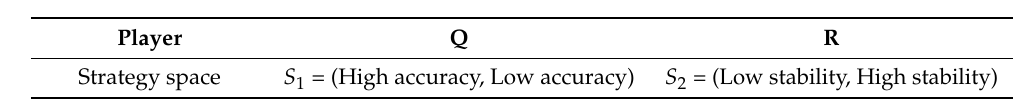
Table 2. Players of the game.